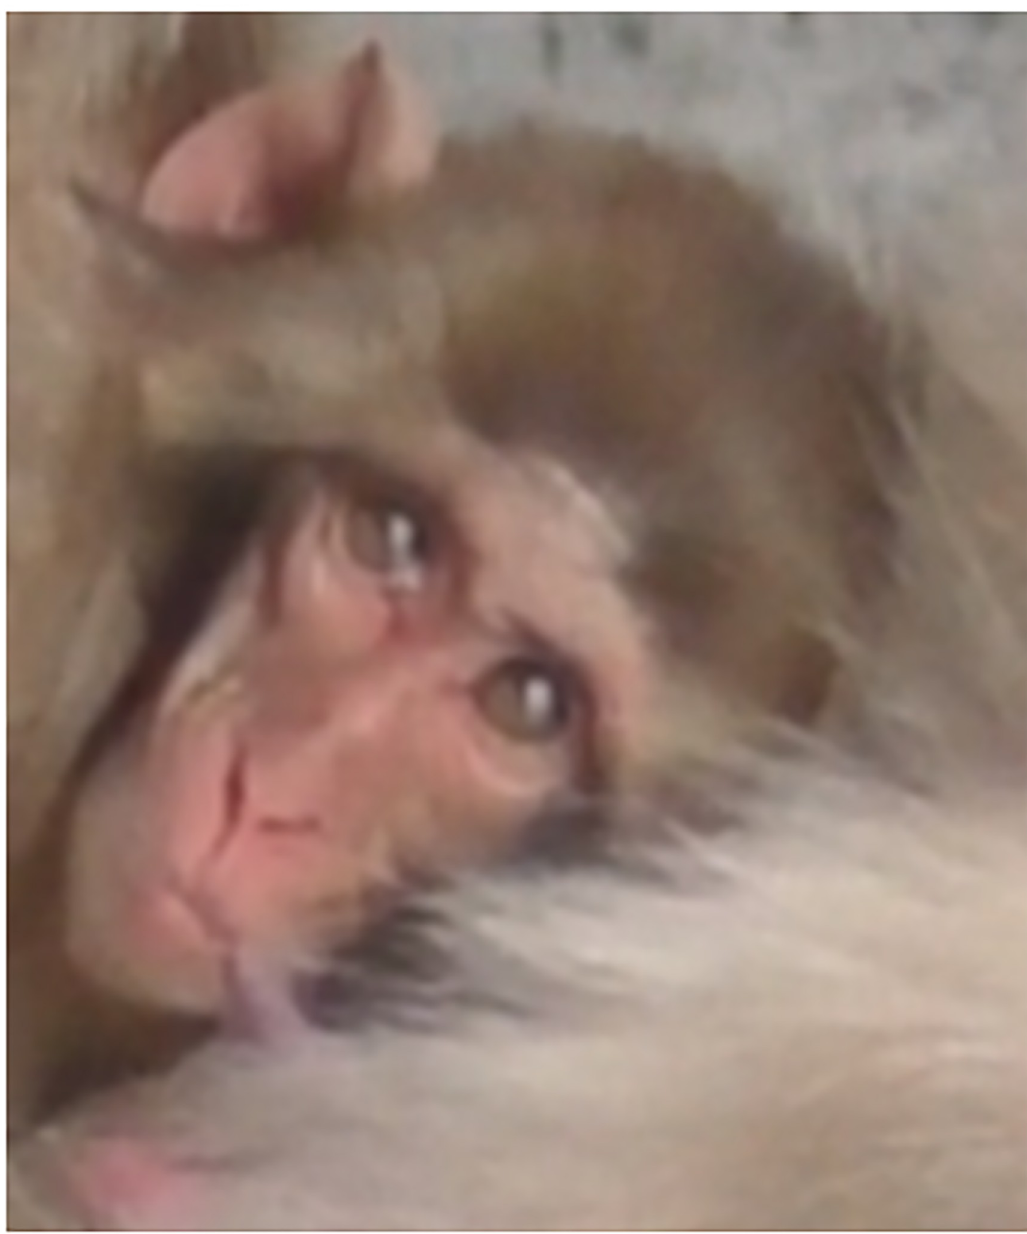
Fig 14. AU18i during